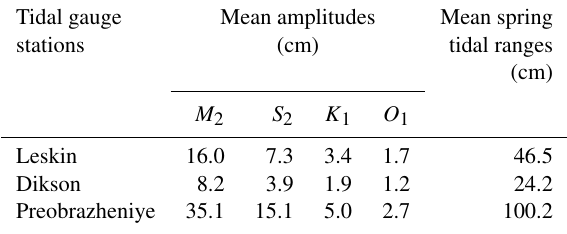
Table 1. The mean amplitudes of four major tidal constituents and the mean spring tidal ranges reconstructed for the Leskin, Dikson, and Preobrazheniye tide gauge